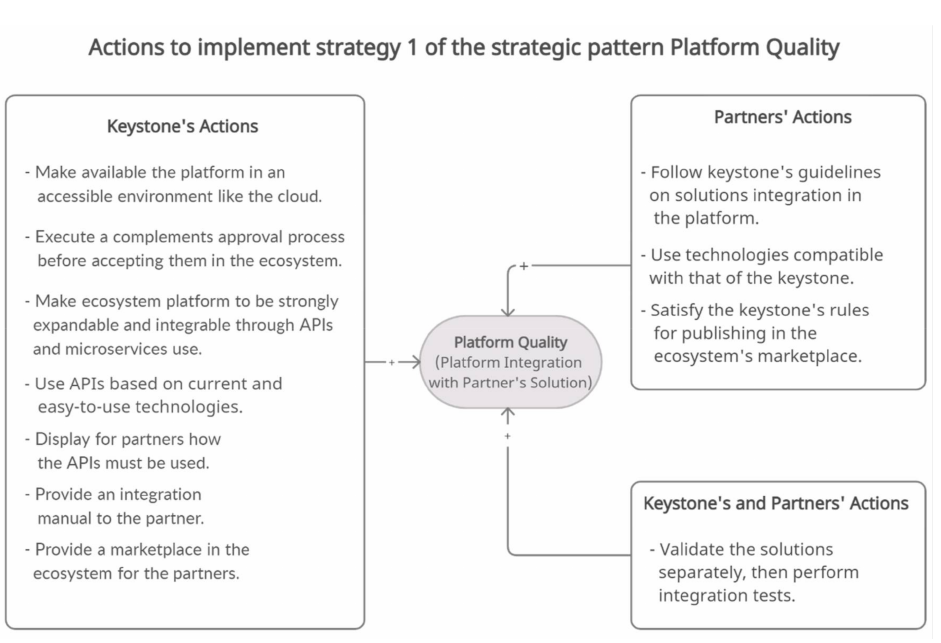
Figure 8. Result of the analysis of the interviews about the quality of the platform: actions that positively impact the platform quality (platform integration with partners’ solution).